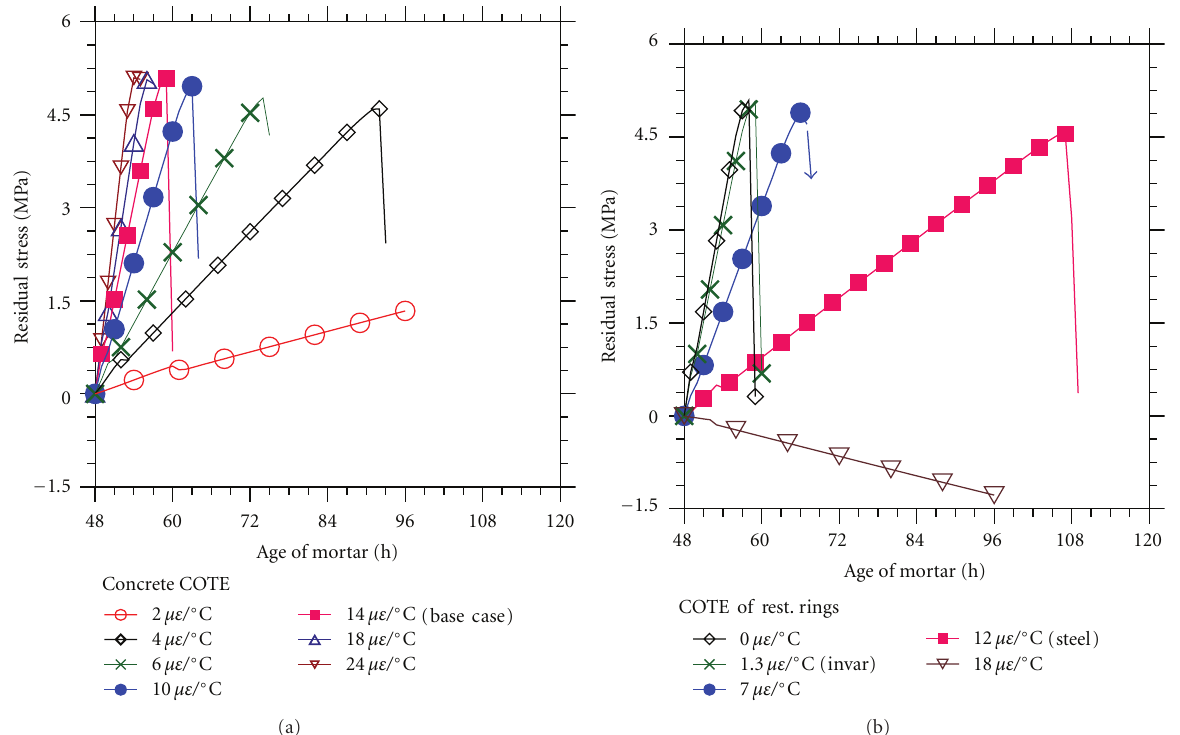
Figure 10: Influence of (a) COTE of the mortar specimen and (b) COTE of restraining rings on the average residual stress